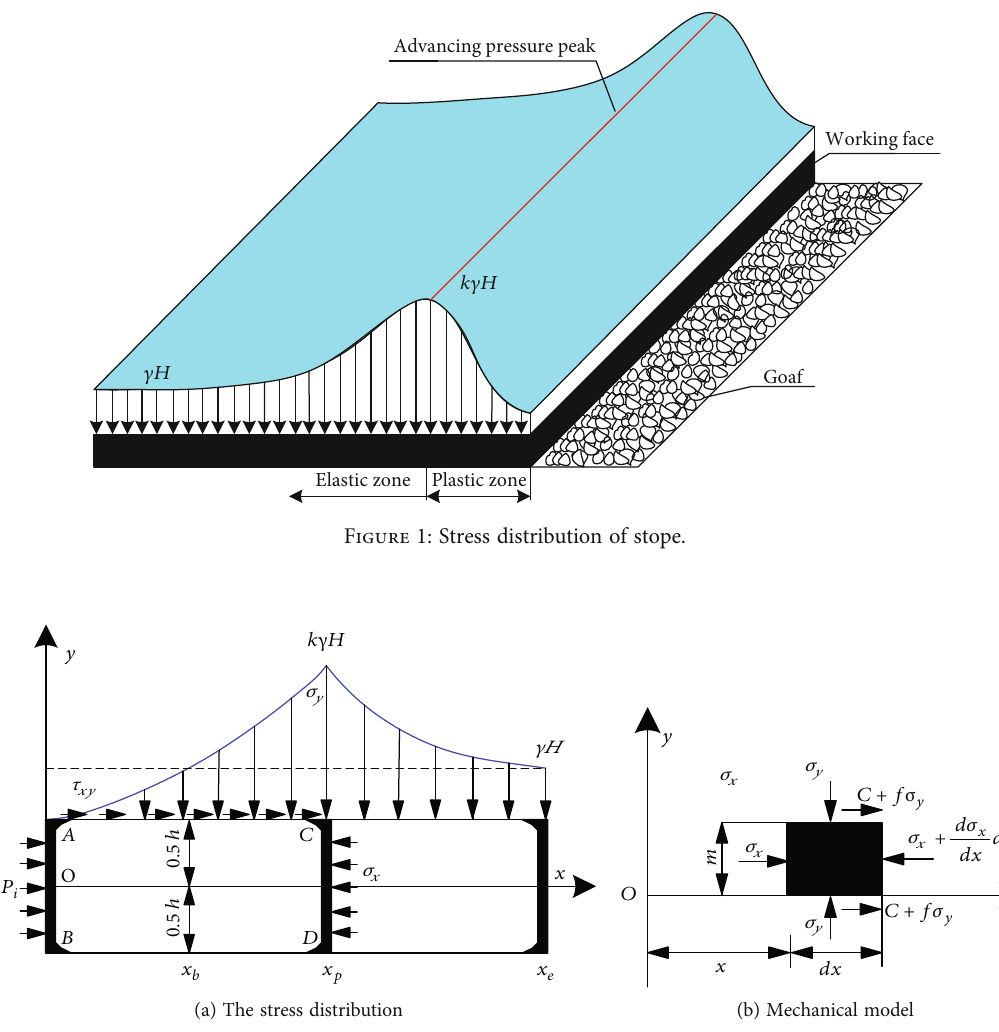
Figure 2: Stress analysis model of coal